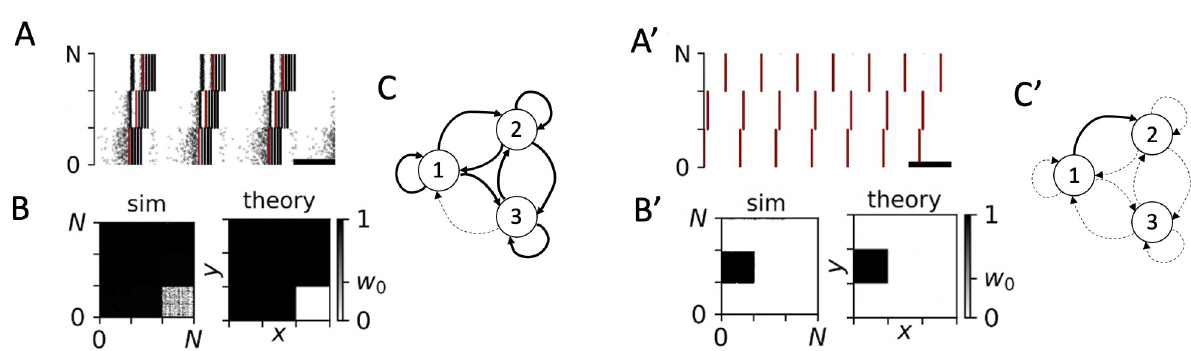
Fig 13. PMCS-induced network structures in which either all-but-one or only one synaptic population was up-regulated while all others were down-regulated. A: Raster plot of simulated spiking activity of LIF neurons 1000 sec after onset of PMCS with burst stimuli with high intraburst frequency and short phase lags between subsequent subpopulations. B: Snapshots of simulated synaptic weight matrix after 1000 sec of stimulation (sim) and the corresponding theoretical prediction obtained from Eq 1 (theory). C: Schematic of stimulation-induced network structure (see caption of Fig 9 for symbols). A’-C’: Same as A-C but for single-pulse PMCS. One phase lag was chosen to be significantly smaller than the others in order to up-regulate only one population of synapses. Parameters: d e = 1 (all panels). In panels A-C, we used A stim = 0.8, an intraburst frequency of 120 Hz, five pulses per burst, f = 5 Hz, and Δ α 1/2 = 0.1. In panels A’-C’, we used single-pulse stimuli with A stim = 0.4, a stimulation frequency of f = 10 Hz, and the phase lags Δ α 1 = 0.1 and Δ α 2 =